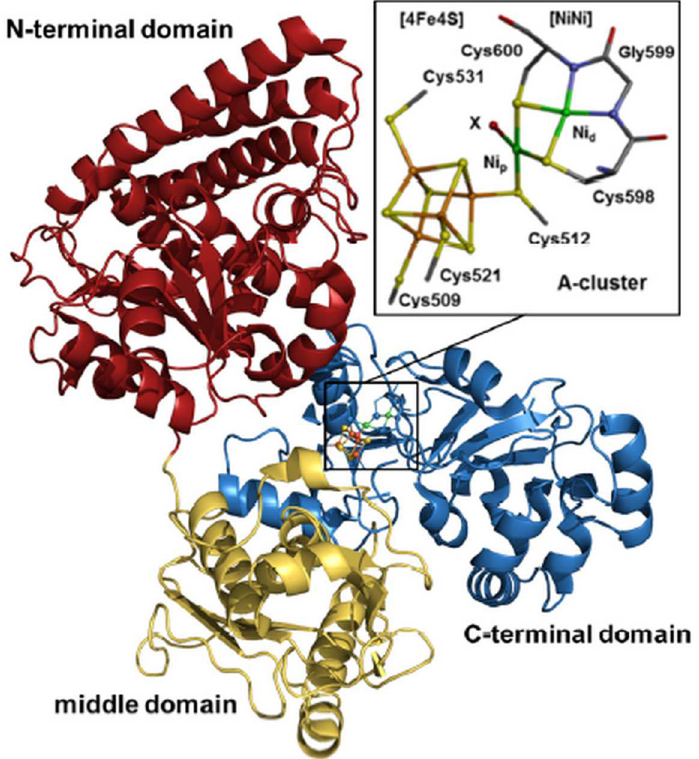
Fig 1. Crystal structure of ACS from C . hydrogenoformans . PDB entry 1RU3, 2.2 Å resolution[15]. Inset, A-cluster in magnification (color code: green, Ni; orange, Fe; yellow, S; red, O; blue, N; grey, C; protons are omitted for clarity). The (distorted) square-planar Ni ions are denotedproximal(p) and distal (d). X marks a ligandmodelled as oxygen.